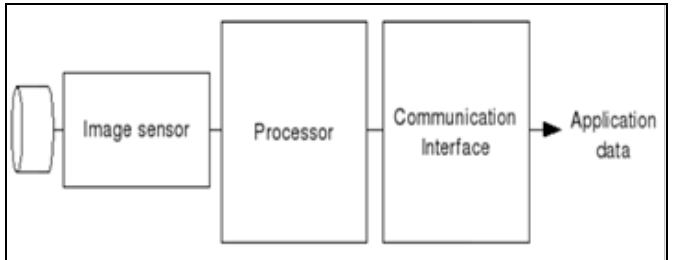
Figure 4: Block diagram of a smart